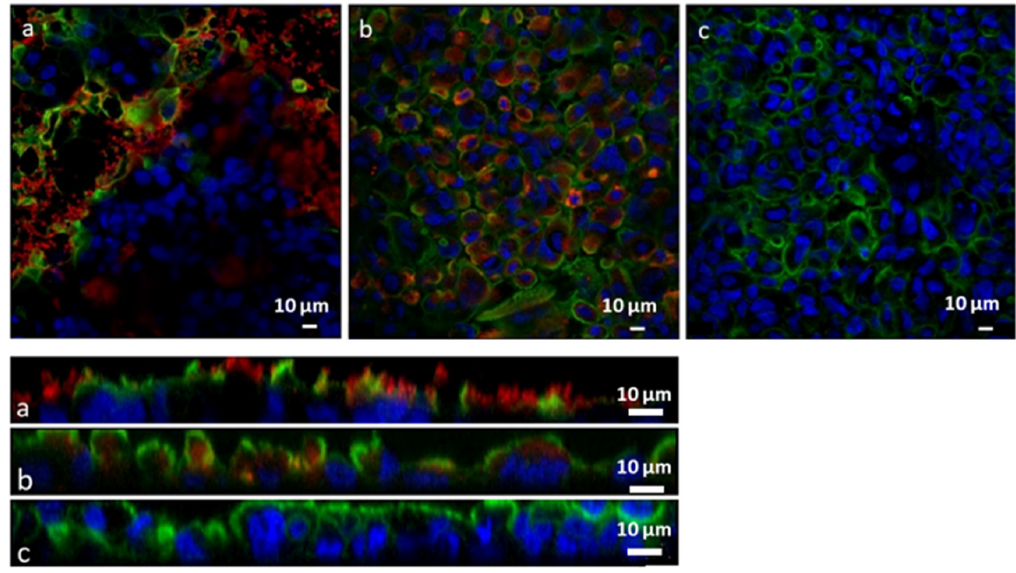
Figure 7. CLSM images ( top , a – c ) and Z-scans ( bottom , a – c ) of the cell co-culture (Caco-2:HT29MTX; 7:3) treated with 500 µg/mL particle suspension for 4 h at 37 °C. ( a ) Thiolated Lip-SeNPs; ( b ) uncoated Lip-SeNPs; ( c ) cell control. The particles (phospholipid layer) were labelled with rhodamine B (red), the cell nuclei were stained with Hoechst (blue) and the cell membranes were stained with Alexa Fluor 488 Phalloidin (green). The scale bars are 10 µm.